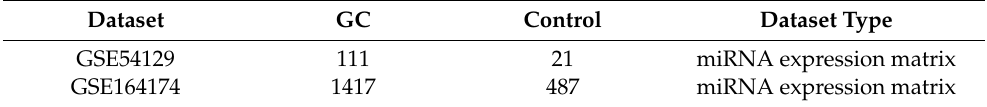
miRNA expression matrix